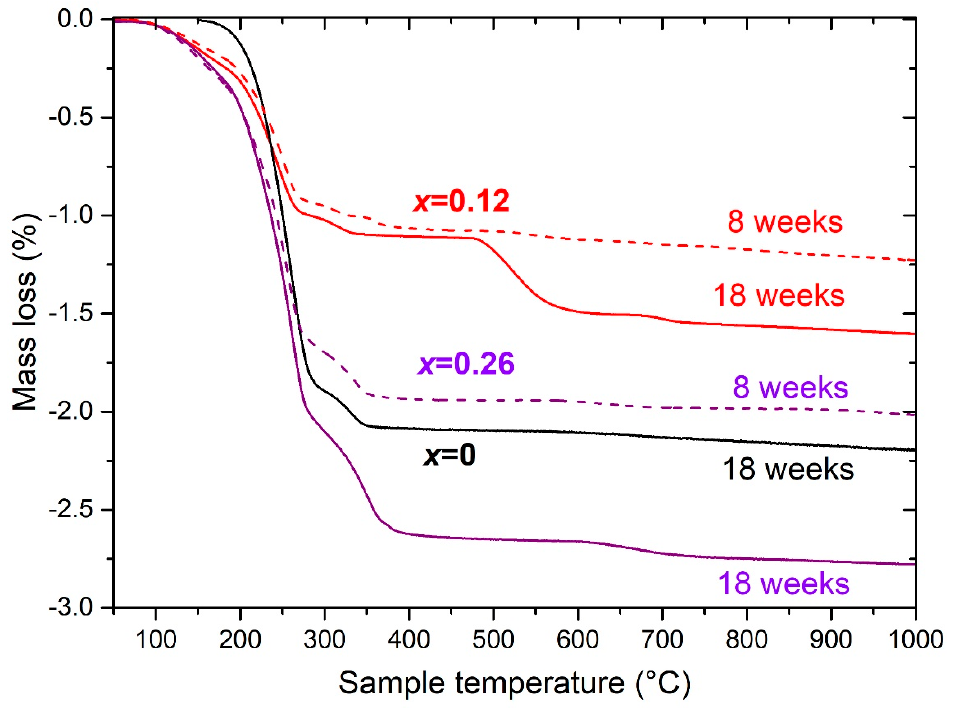
Figure 7. TGA of Sm 2 Mn x Ni 7 − x for x = 0 (black), x = 0.12 (red) and x = 0.26 (purple); after 8 weeks (dotted line) and 18 weeks (full line) of corrosion.